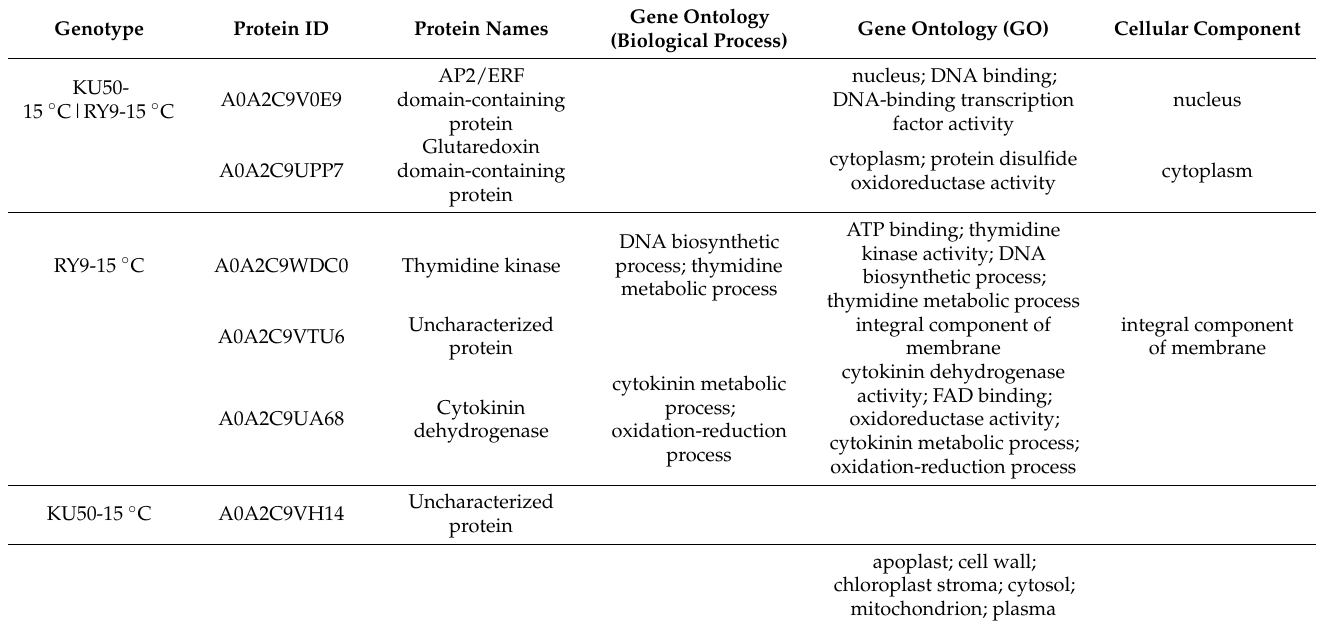
Table 1. The differentially expressed proteins in leaves of cassava cvs. Rayong 9 and Kasetsart 50 exposed to low- (15 ◦ C) and high-temperature (45 ◦ C) stress compared to those at normal temperature (30 ◦